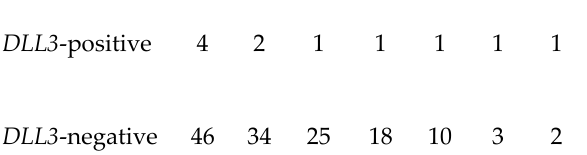
Figure 5. Overall survival according to presence (red) or absence (green) of DLL3 . Log-rank testing was used to compare survival outcomes.